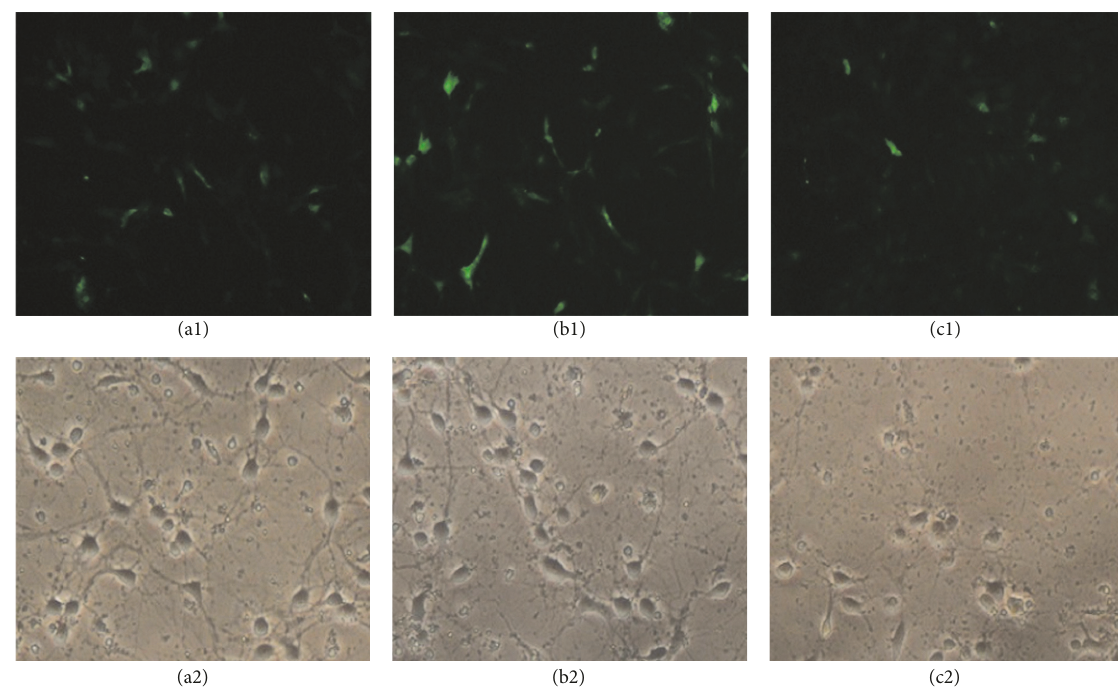
Figure 1: The optimal transfection screening for pEGFP-C1-CAV1 plasmid in hippocampal neurons under the plasmid-liposome at the ratio of 2.5 :3.75 (a1), 5: 7.5 (b1), and 7.5 : 11.25 (c1) was evaluated by EGFP fluorescent intensity, respectively. Meanwhile, the optimal transfection screening for pEGFP-C1-CAV1 plasmid in hippocampal neurons under the plasmid-liposome at the ratio of 2.5 : 3.75 (a2), 5: 7.5 (b2), and 7.5 :11.25 (c2) was also evaluated by the morphology and nerve network of hippocampal neurons,